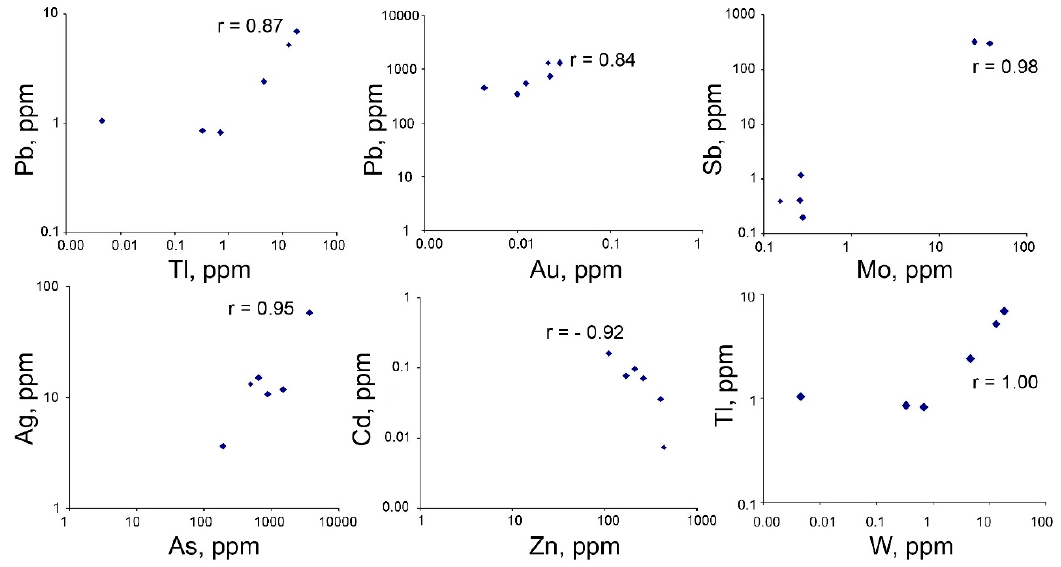
Figure 12. Log ‐ log plots for selected trace elements in reniform chalcopyrite (ppm).